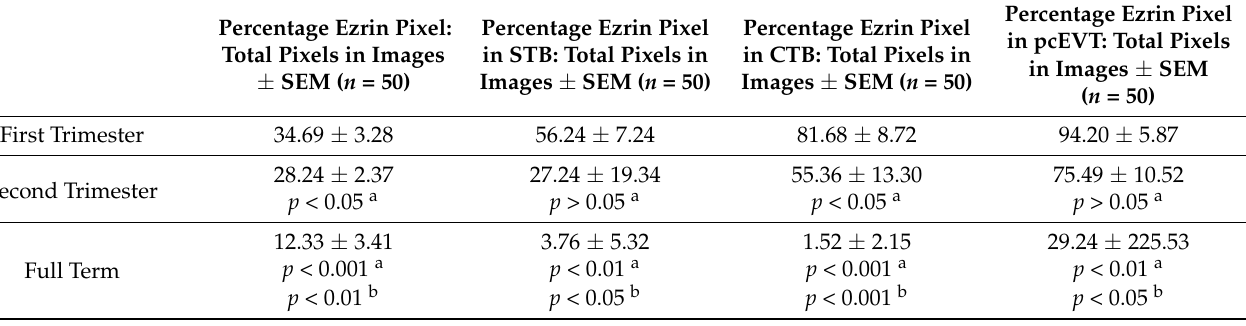
Table 1. Ezrin expression reduces throughout the gestation in human placental tissues in the different trophoblast